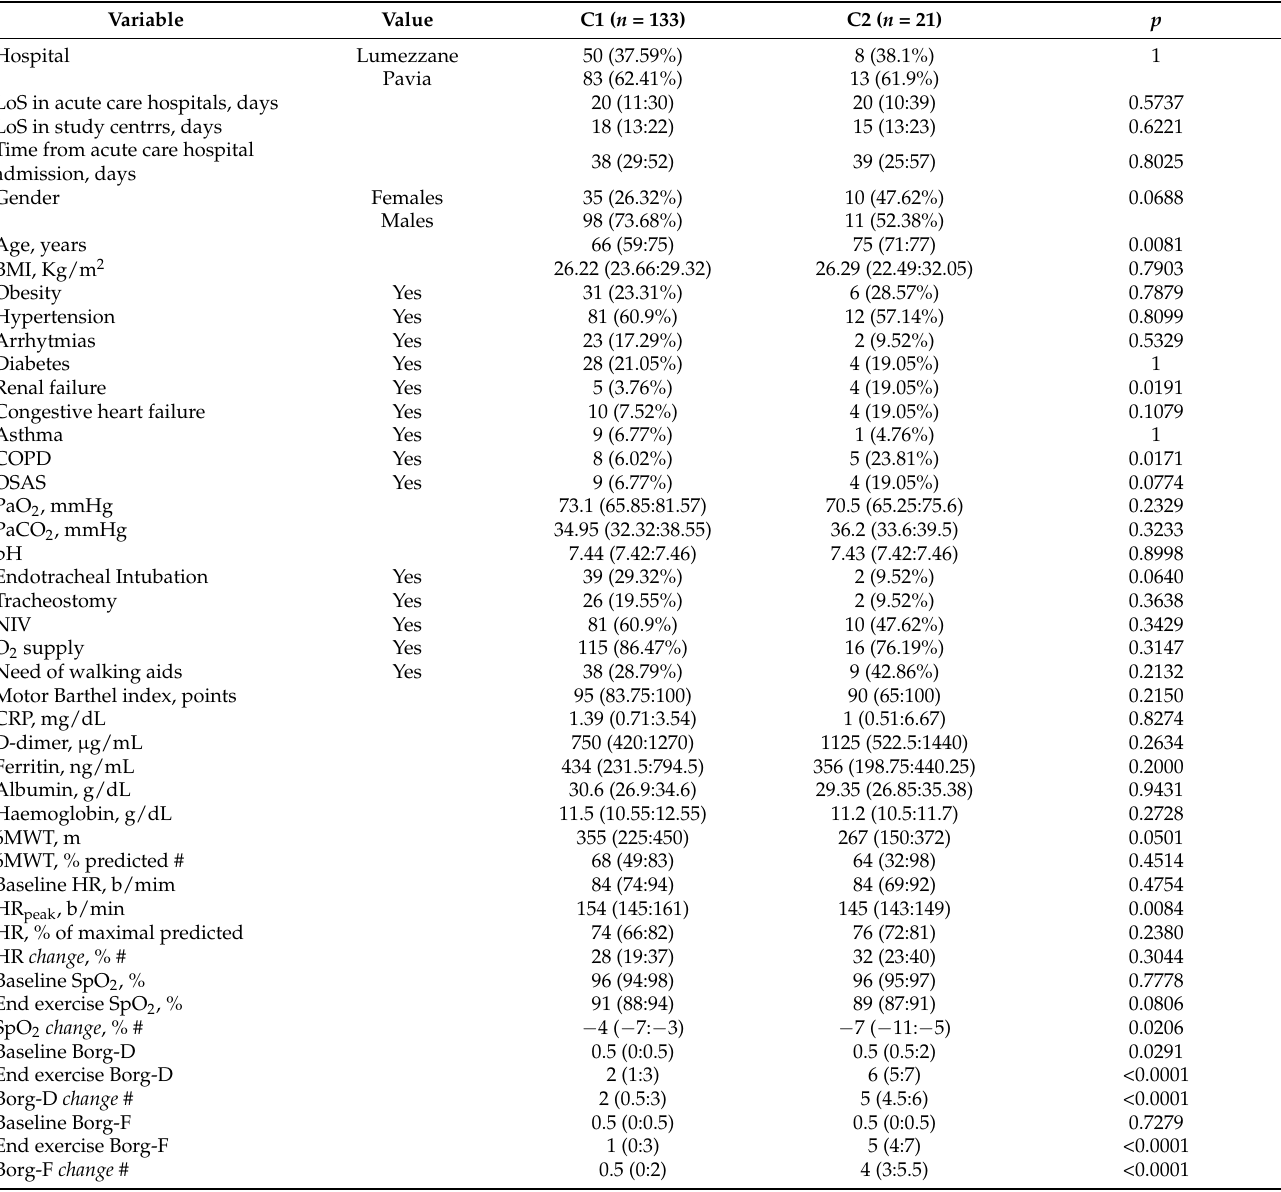
Table 2. Results from testing for differences in variables distribution between